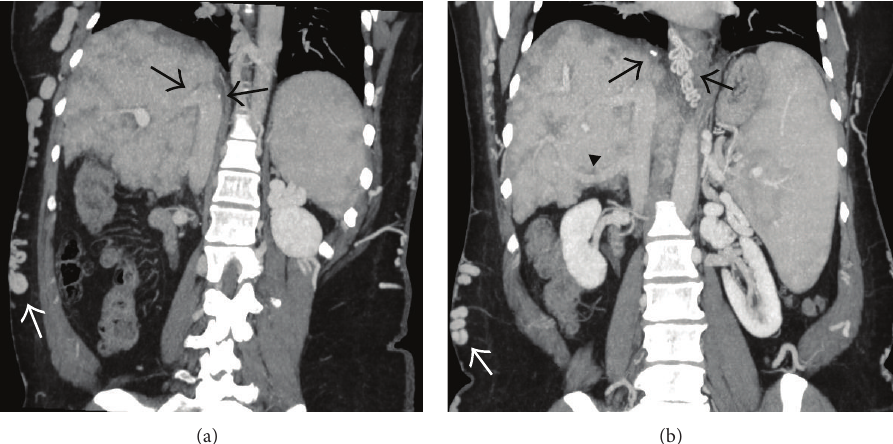
Figure 21: Coronal CECT images demonstrating mural calcification involving the IVC (long thin black arrows in (a) and (b)) secondary to chronic thrombosis. Multiple superficial abdominal wall and paraesophageal collaterals (white arrows and short thick black arrow, resp.) along with a prominent accessory vein (arrowhead) can also be